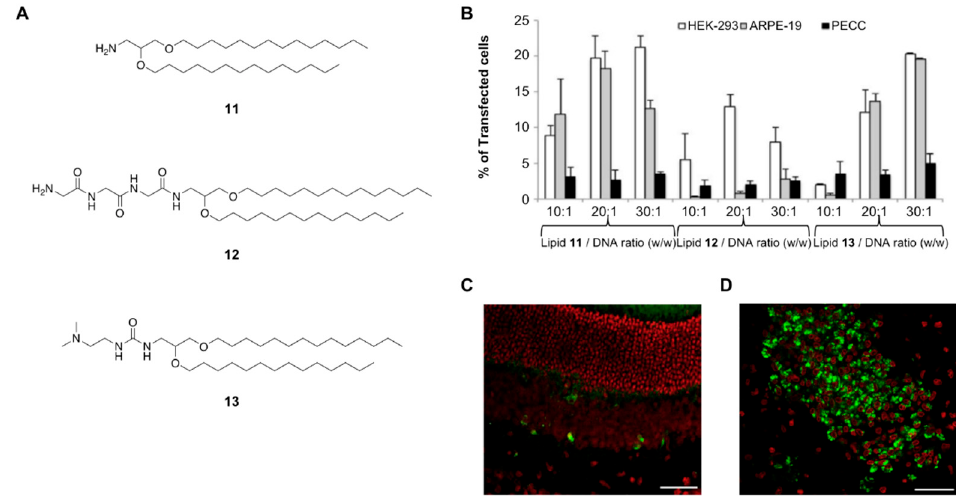
Figure 5. ( A ) Preparation of cationic niosome-based formulations containing lipids 11 , 12 and 13 , respectively and using SQ as a helper lipid; ( B ) in vitro gene transfection experiments after a 72-h incubation period at several mass ratios in three cell lines: HEK-293, ARPE-19 and PECC cells; ( C ) EGFP gene expression in retina after subretinal injection; ( D ) EGFP gene expression in the retina after intravitreal injection. Adapted with permission from ref. [82]. Copyright 2016, Elsevier B.V.